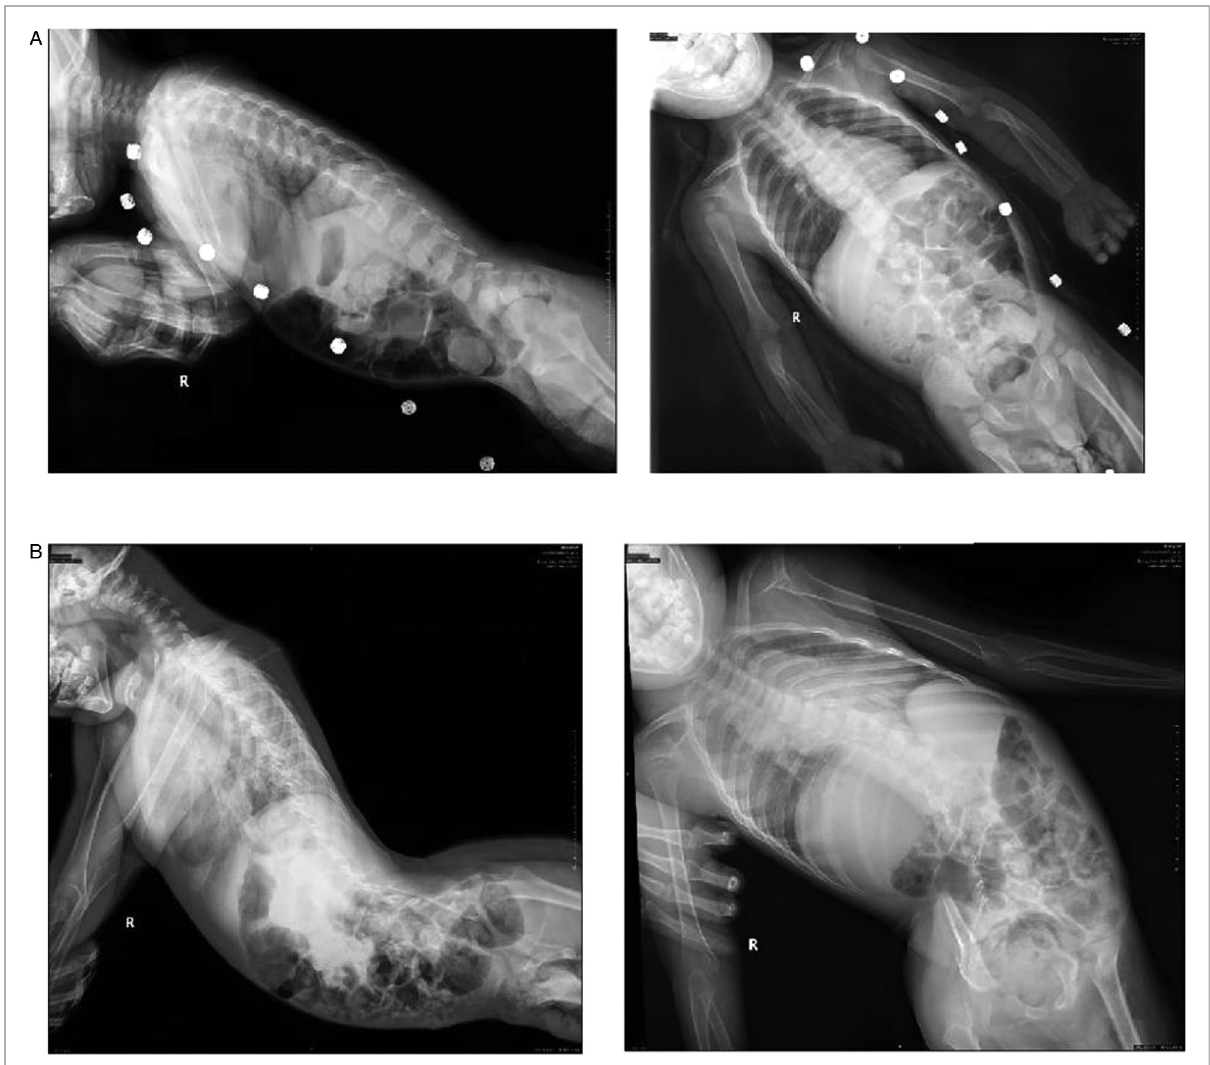
FIGURE 4 The spine x-rays. ( A ) The spine x-rays of the proband; ( B ) the spine x-rays of the elder brother. The spine x-rays showed that the spine of the proband was normal and the elder brother had severe scoliosis and cervical